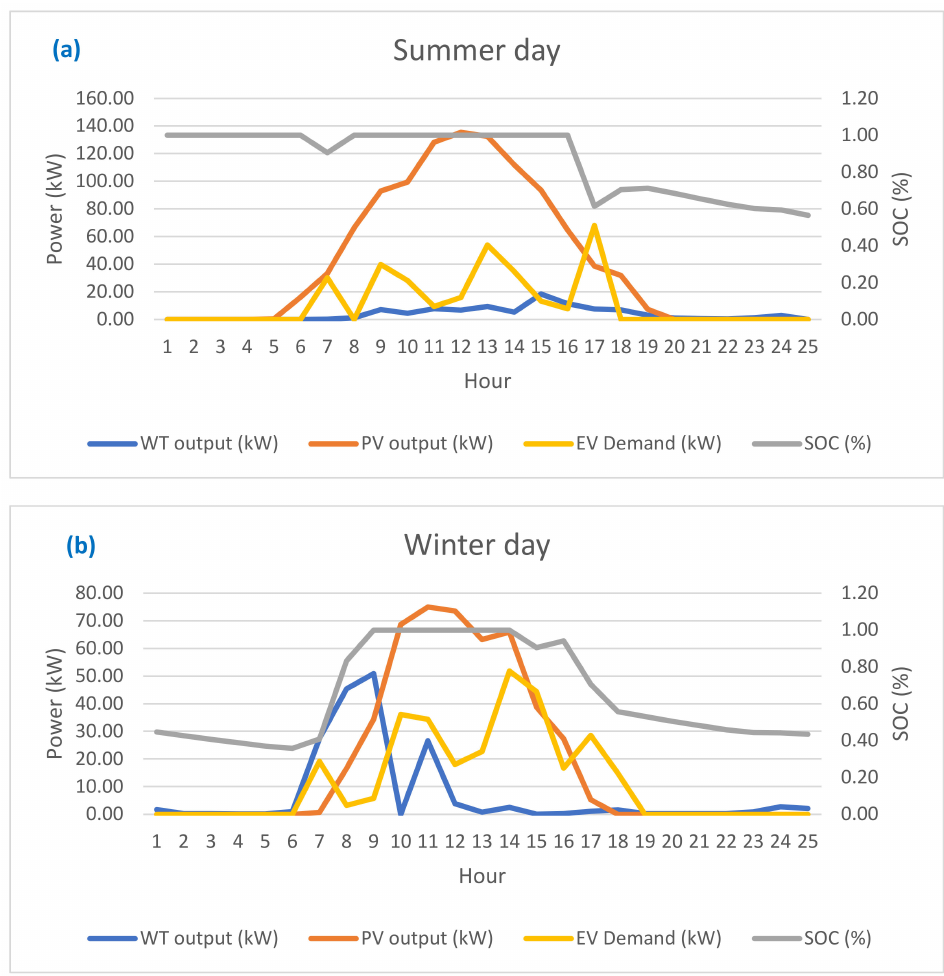
Figure 13. The performance evaluation of the proposed system on ( a ) summer and ( b ) winter